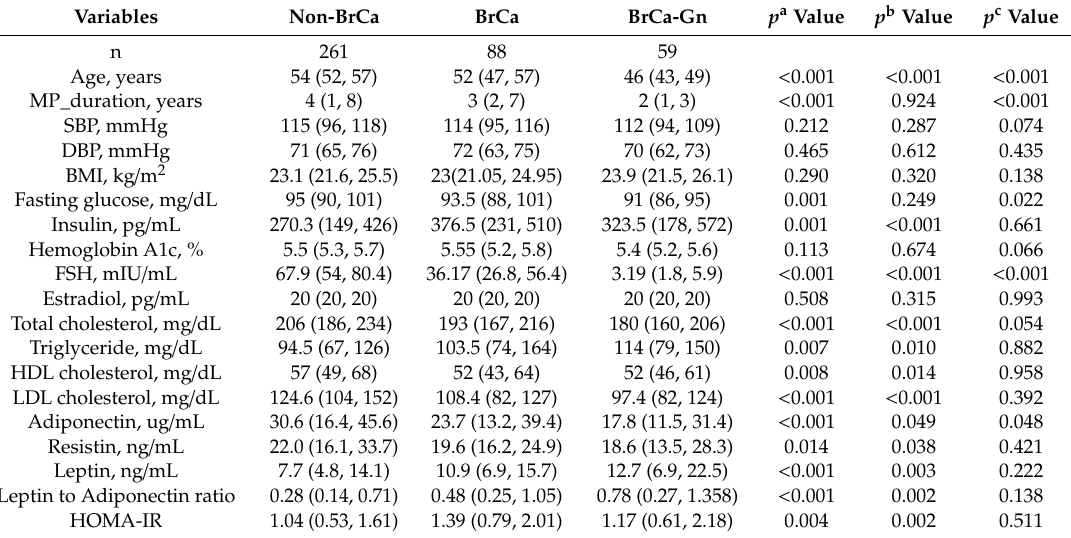
Table 1. Characteristics of the postmenopausal participant groups.